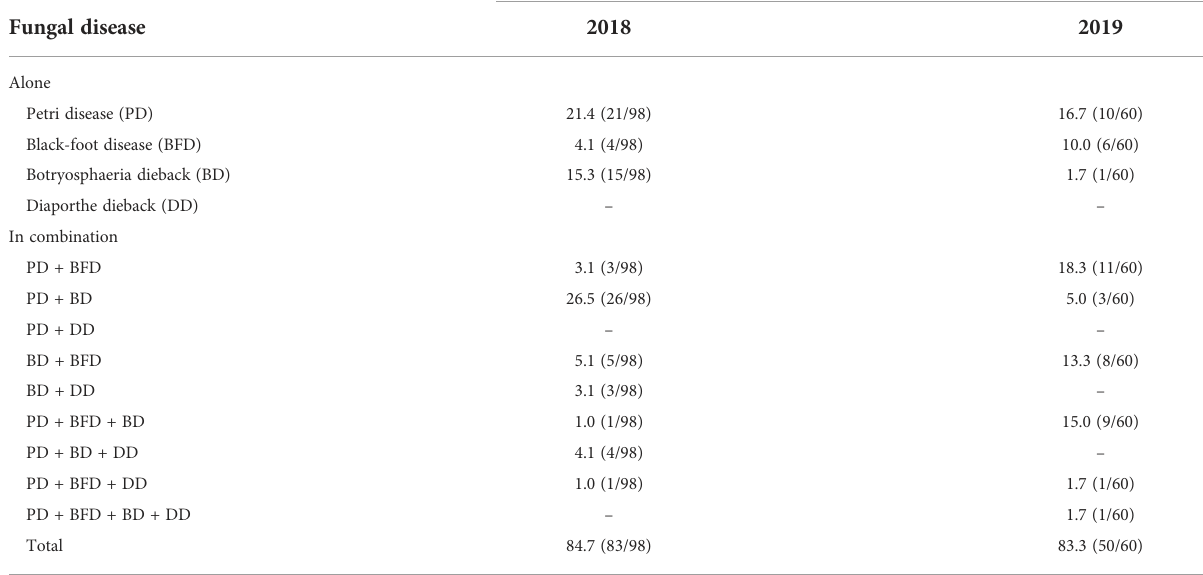
Frequency of infected plants(% disease incidence)